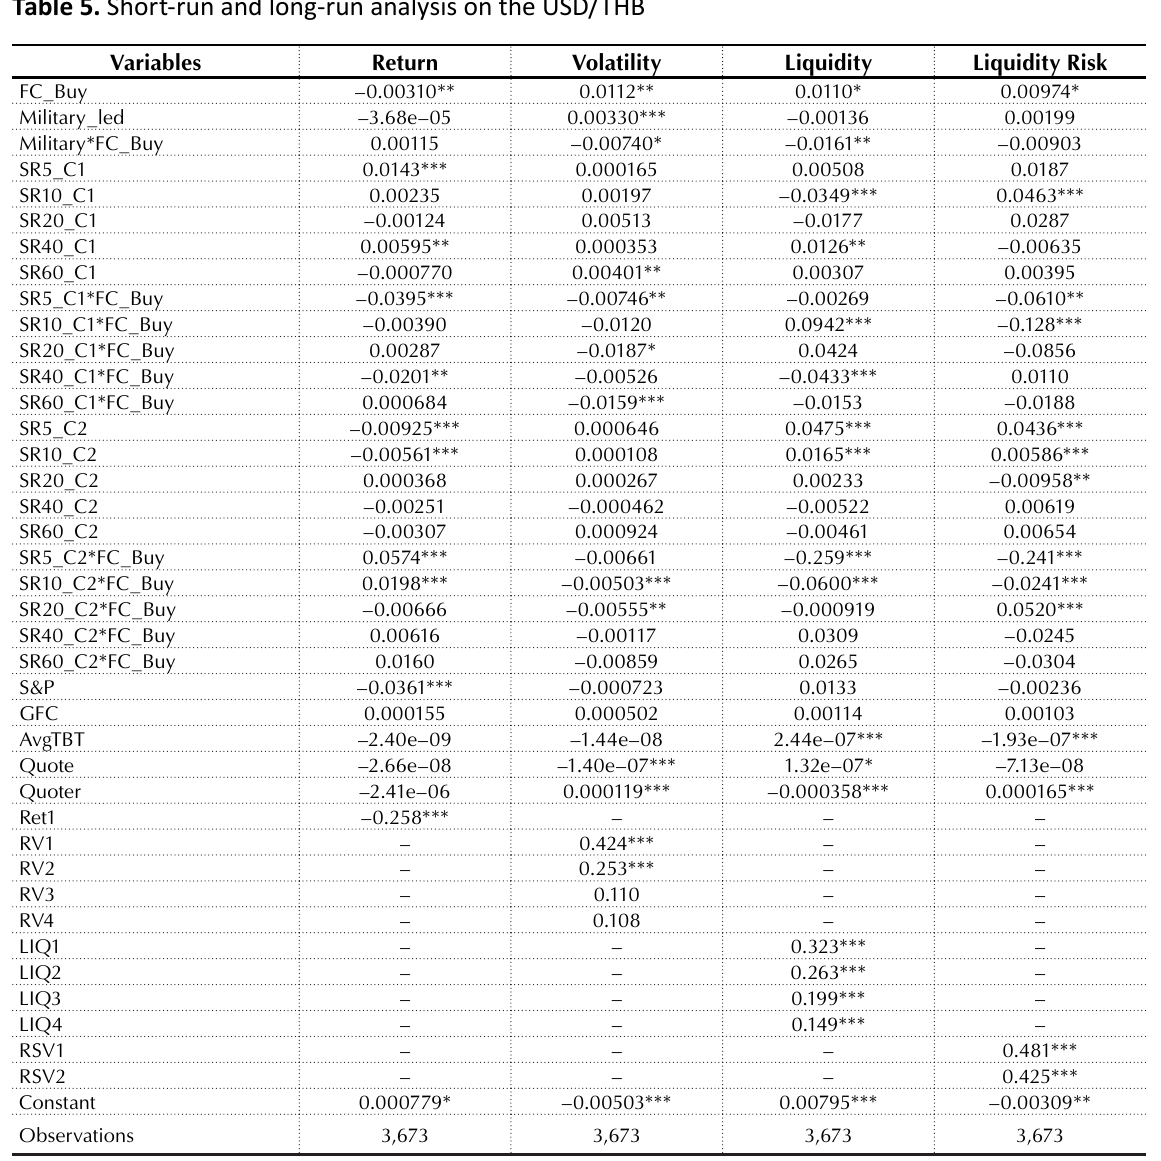
Table 5. Short-run and long-run analysis on the